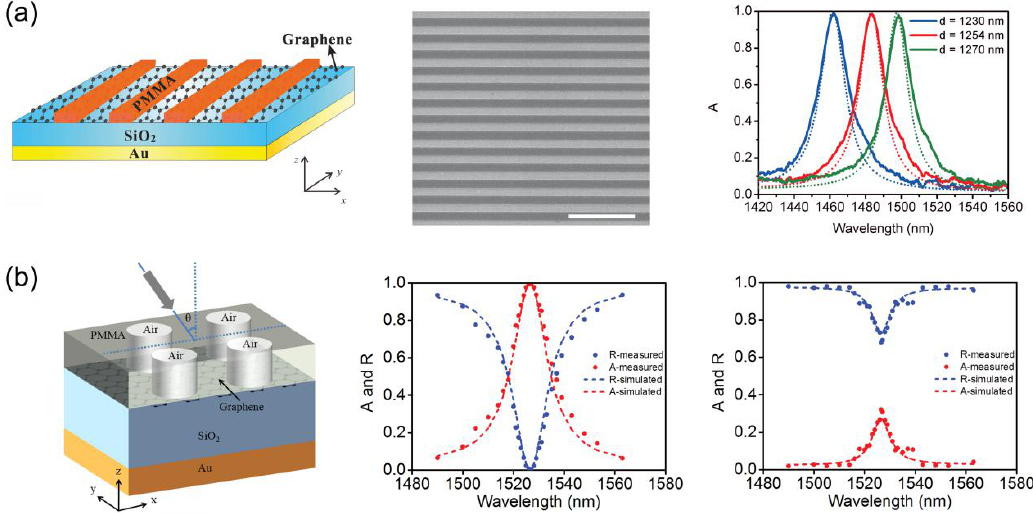
Figure 6. ( a ) Left: schematic image of the perfect absorption structure realized by coupling graphene with 1D PMMA grating. Middle: SEM image of a fabricated structure, the scale bar equals 5 µ m. Right: measured (solid line) and simulated (dashed line) absorption spectra of structures with different grating periods under normal incidence of a white light source with TE polarization [64]. ( b ) Left: schematic image of the perfect absorption structure realized by coupling graphene with 2D subwavelength grating. Middle: measured (dot line) and simulated (dashed line) spectra of a fabricated perfect absorption structure. Right: measured (dot line) and simulated (dashed line) spectra of a resonant structure without graphene [65]. Reproduced from references [64,65], with permission from Wiley, 2016; with permission from Optical Society of America,